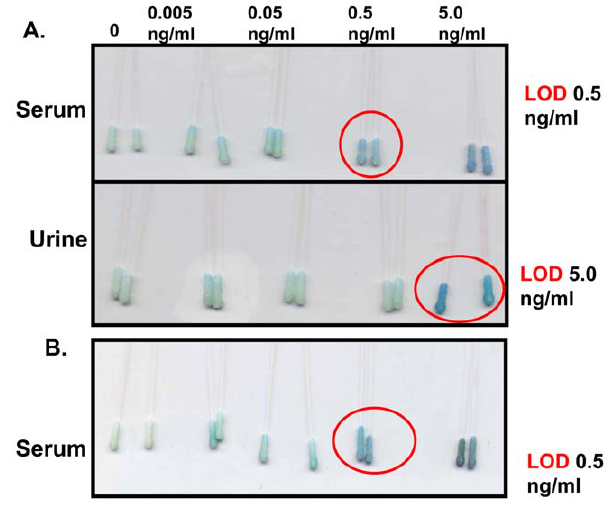
Figure 4. Immunoswab in different matrices. A: The immunoswab performed after spiking the BSA-Hex antigen in serum and urine and the limit of detection (LOD) was found to be 0.5 and 5.0 ng/ml in respective matrices (encircled in red). B: The immunoswab performed after spiking the bacterial LAM isolated from M. tuberculosis H37Rv, in serum and the LOD was found to be 0.5